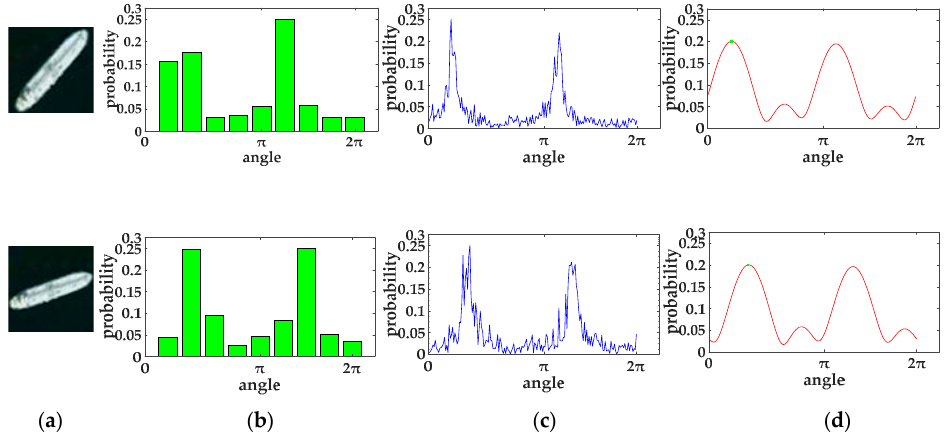
Figure 6. Different types of gradient histograms. ( a ) Input image patches with different angles. ( b ) The discrete gradient histograms. ( c ) The continuous gradient histograms. ( d ) The Fourier smoothing gradient histograms with M = 4. The angle value corresponding to the green point is the main direction of the target. The discrete gradient histogram has poor orientation behavior while continuous Fourier smoothing histogram simply shifts